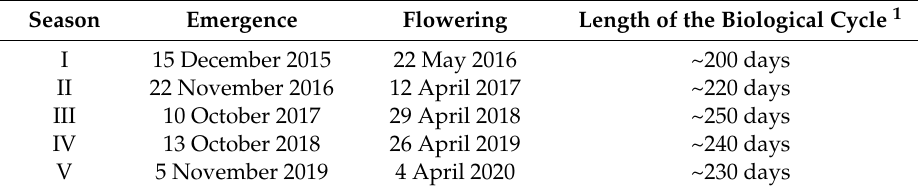
Table 6. Emergence, flowering and length of the biological cycle of subterranean clover among the five growing seasons under